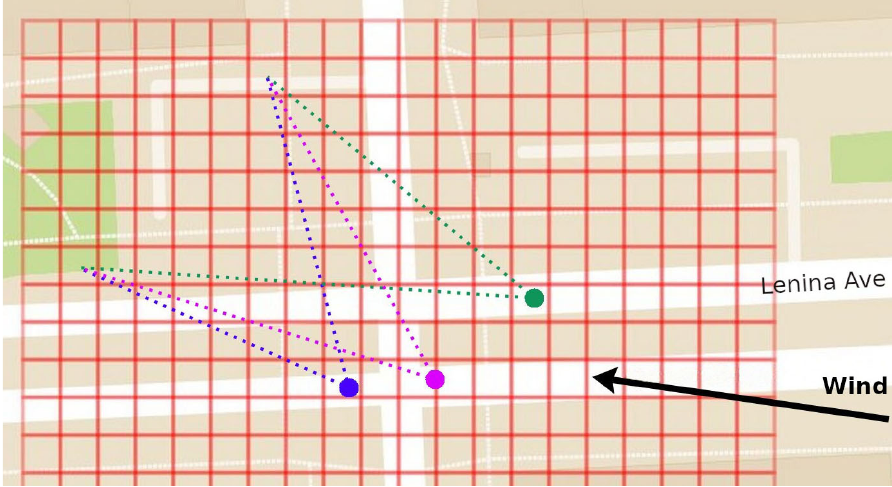
Figure 5. Calculation of the concentration from vehicles to the centers of the squares.